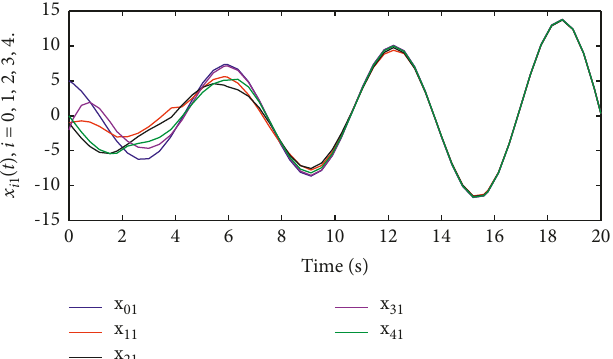
Figure 5: The state x i 1 of the multi-agent